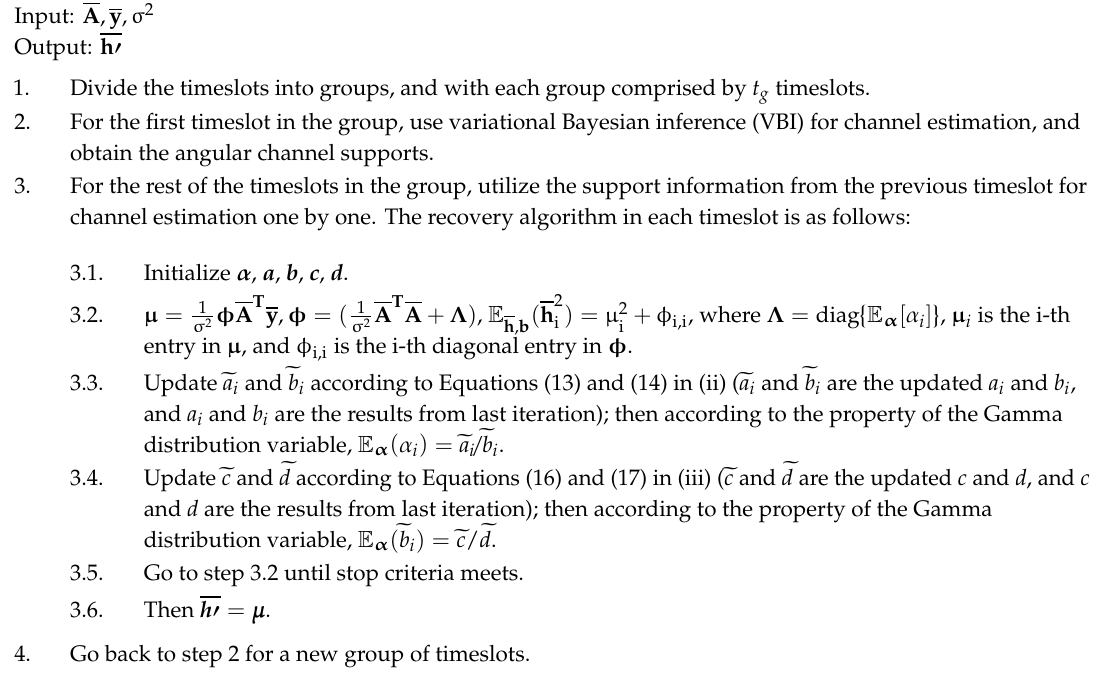
Algorithm 1 Downlink channel estimation with variational inference algorithm and overcomplete